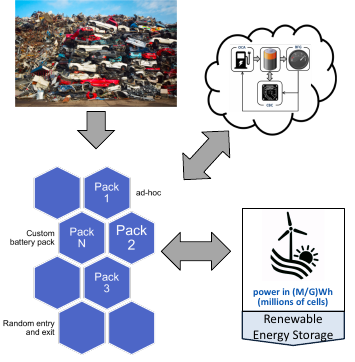
Fig. 2: Battery Powered Applications. Figure 3. Battery reuse: from scrapyard to powering living rooms. Millions of vehicles are scrapped each year due to accidents. In the case of electric vehicles, the batteries could be reused store renewable energy. However, more research needs to be done about managing used batteries of various size, chemistry and